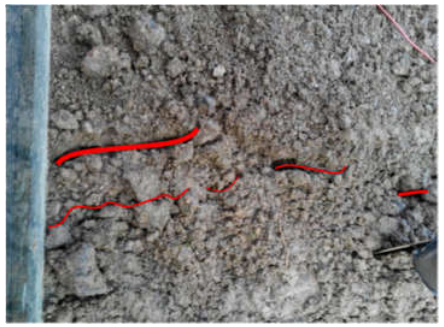
Figure 9. Cracks on sides of the slope (Test 3).